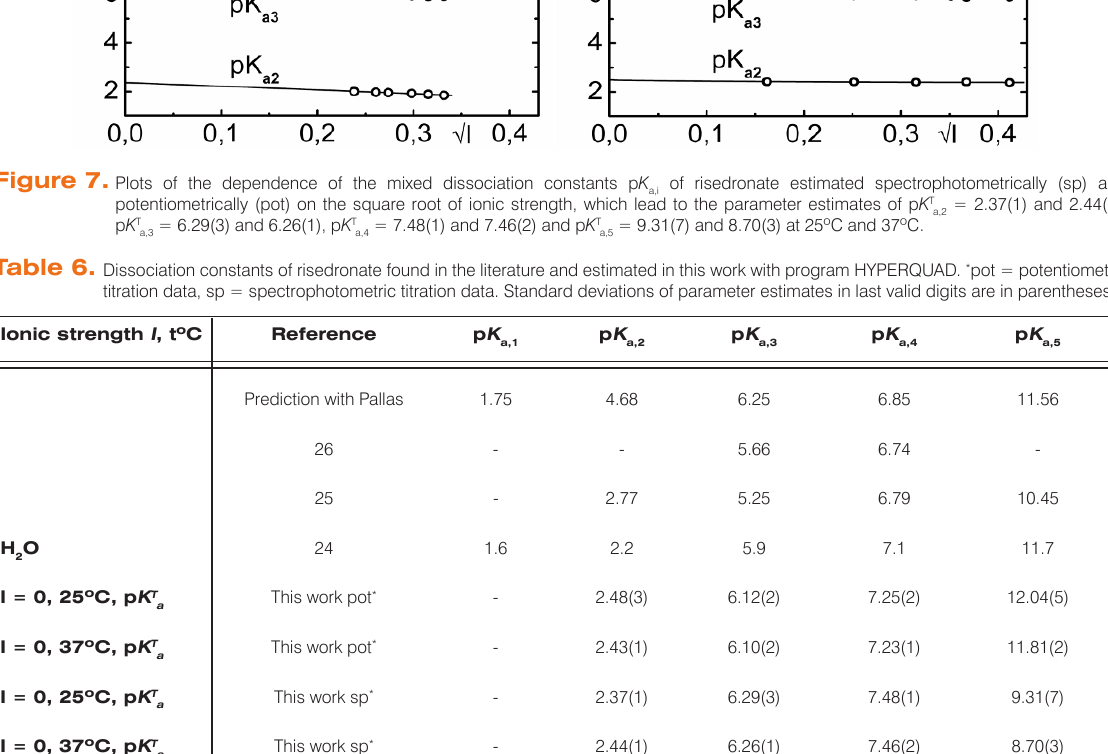
= 2.37(1) and 2.44(1), a,2